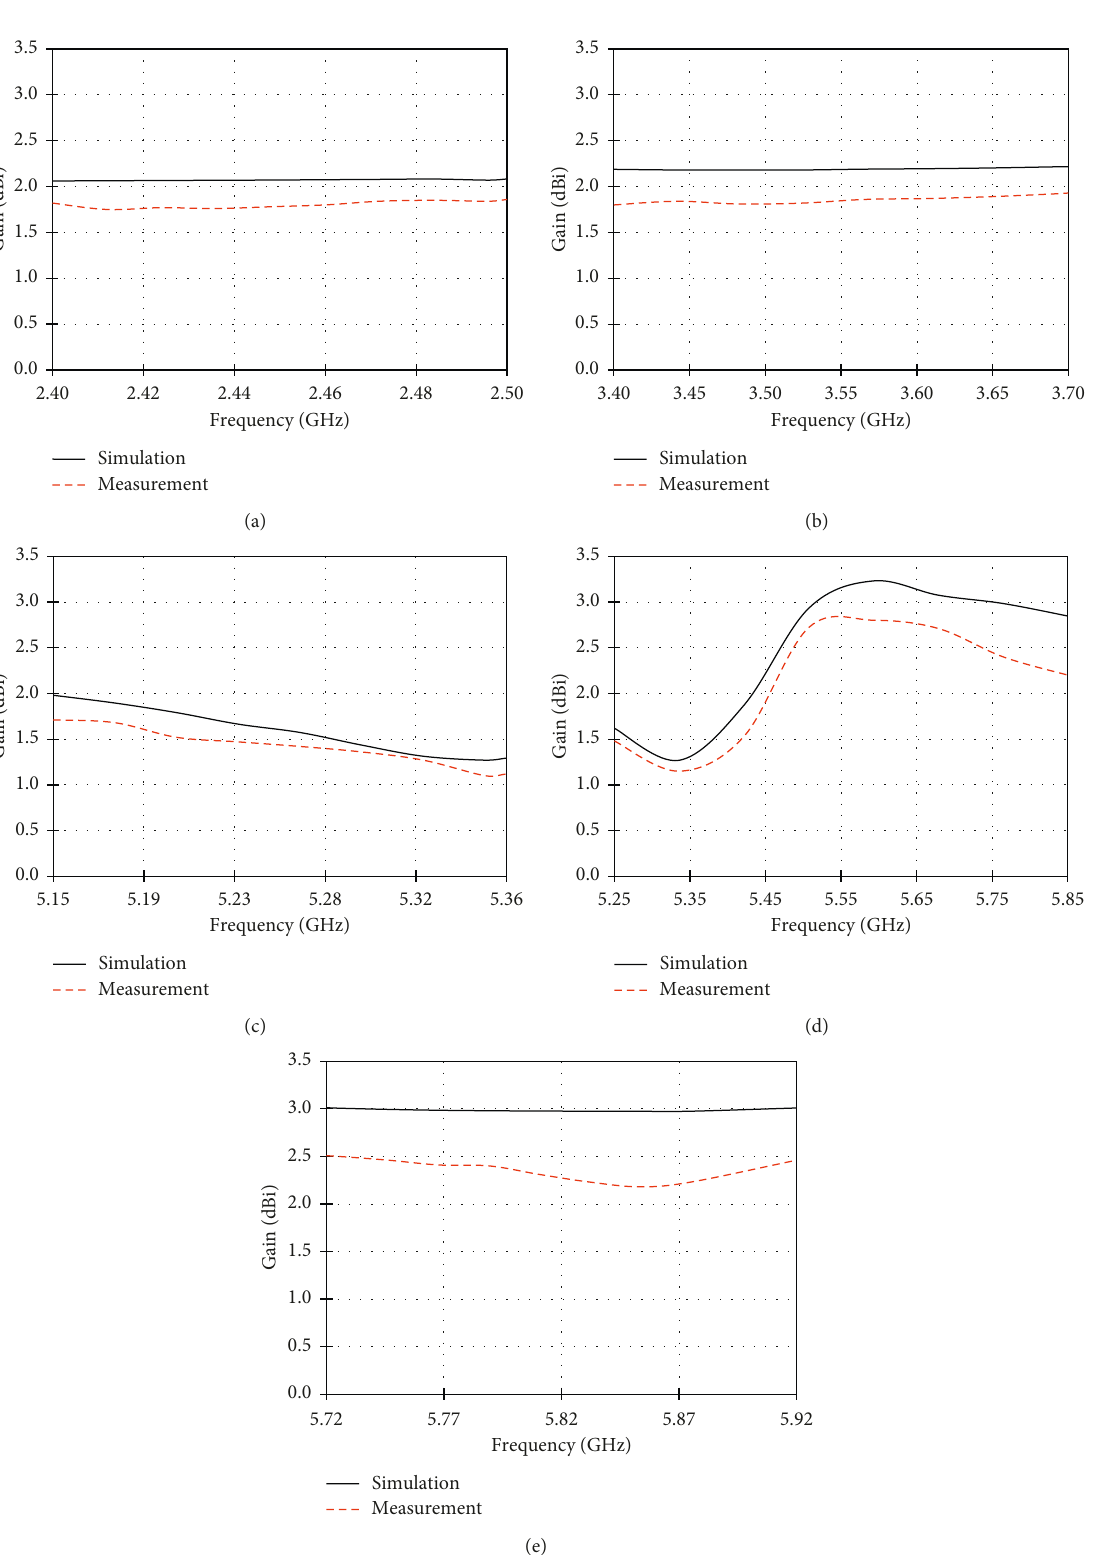
Figure 13: Simulated and measured gain of the WLAN/WiMAX triband antenna at (a) 2.4, (b) 3.5, (c) 5.2, (d) 5.5, (e) and